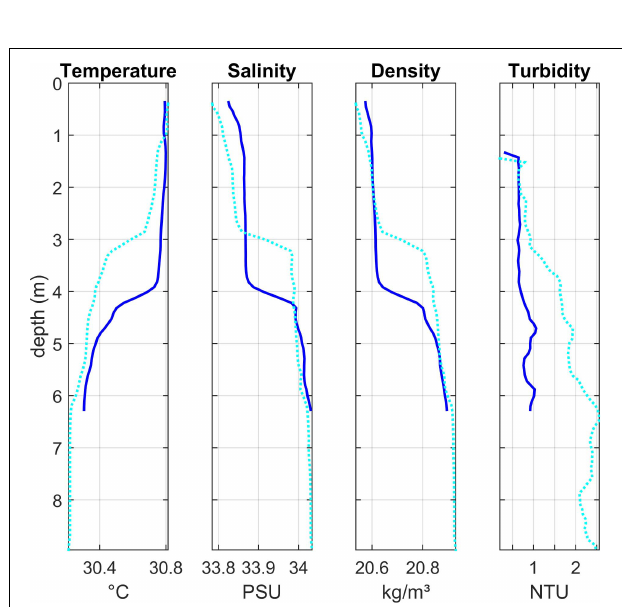
FIGURE 5 | Depth profiles of water column properties at two stations in the shallower central area of the lagoon (Region 2): Lagoon_04 (dark blue solid line) and Lagoon_03 (light blue dotted line). See Figure 1 for station